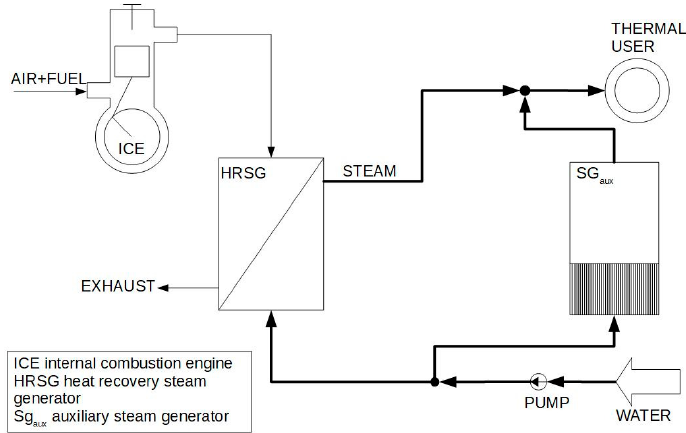
Figure 3. Scheme of the internal combustion engine cogeneration unit taken into consideration.